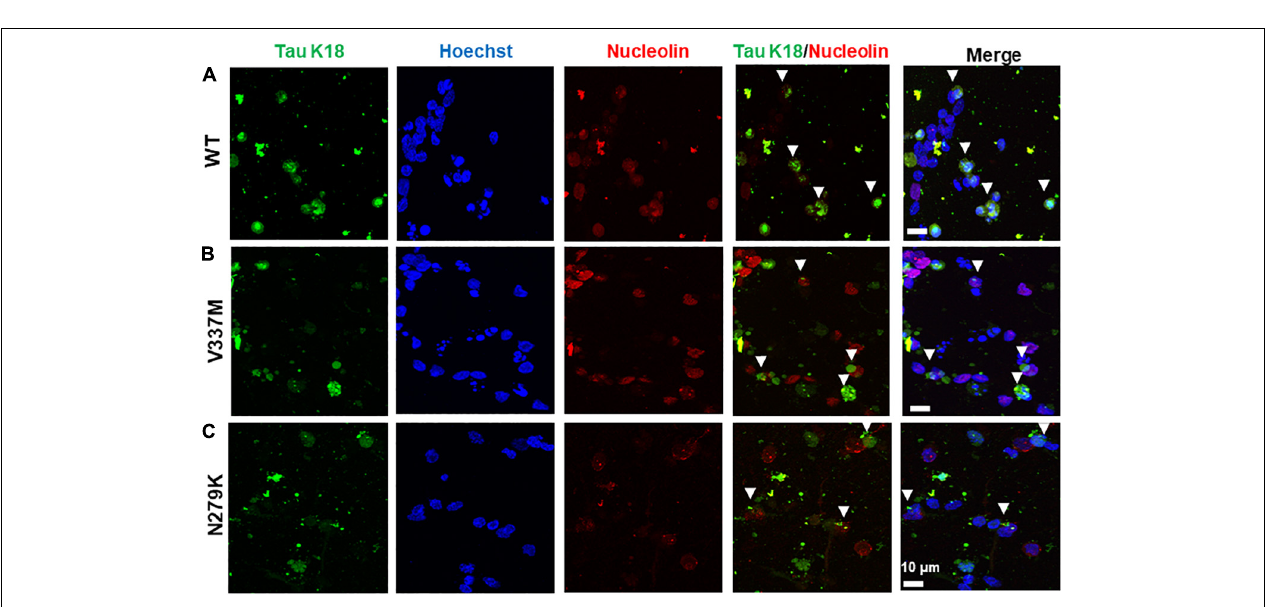
FIGURE 7 | Internalized tau K18 oligomers in hiPSC-derived neurons co-localize with endogenous tau bearing the HT7 ( 159 PPGQK 163 ) mid-region epitope. Extracellularly applied oligomers of tau K18-WT (A) , K18-V337M (B) , and K18-N279K (C) oligomers internalized in hiPSC-derived neurons co-localized with endogenous tau in the soma and the neurites. White arrowheads show sites of co-localization. Scale bar = 10 µ m for all images. Figure extension in Supplementary Figures S8A–C .